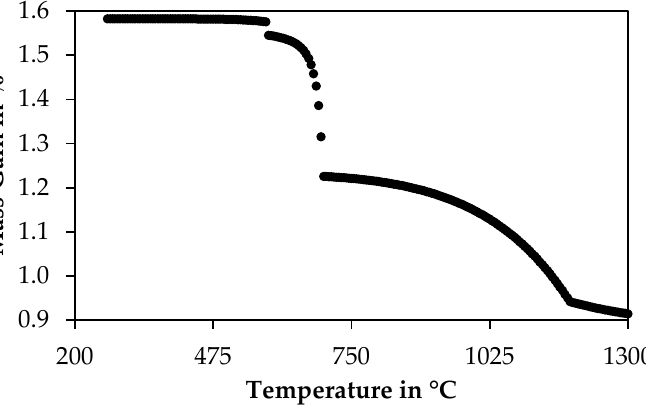
The thermochemical simulation predicts slightly higher values compared to the